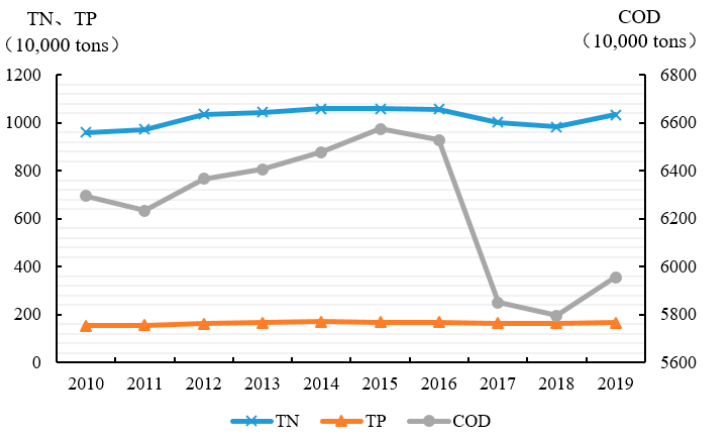
Figure 1. Average amount of TN, TP, and COD emissions from 2010 to 2019.